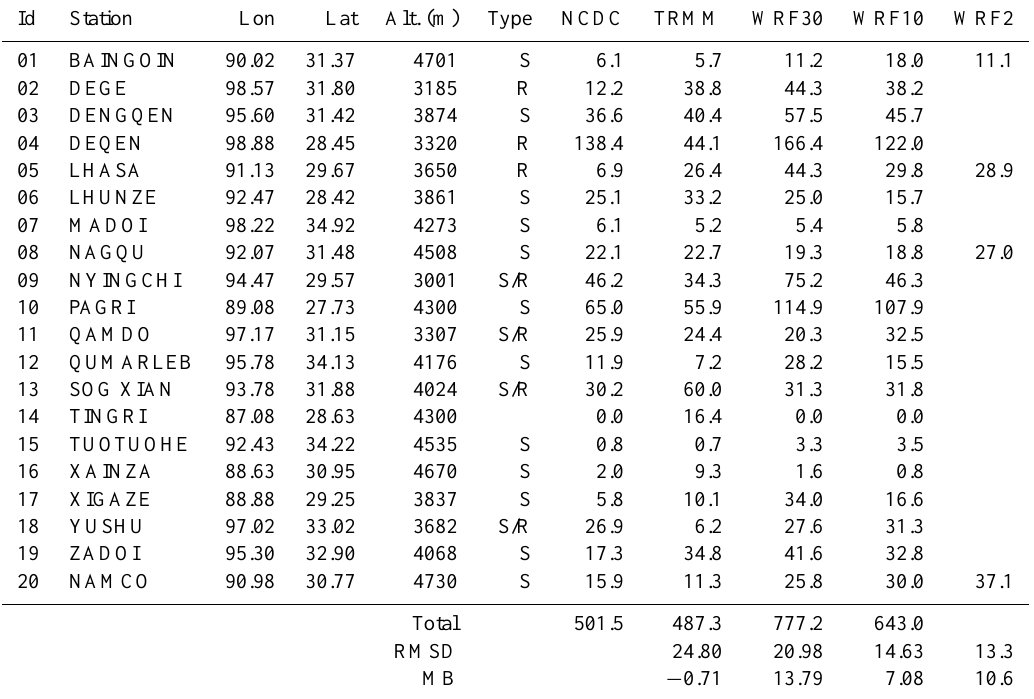
Table 3. Observed precipitation (mmweek − 1 ) at each weather station (19 NCDC stations and the Nam Co weather station) in comparison to the TRMM, WRF30, WRF10 and WRF2 results. The observed type of precipitation is indicated by R (rain) or S (snow). Root Mean Square Deviation (RMSD) and Mean Bias (MB) are indicated for each grid with respect to the NCDC